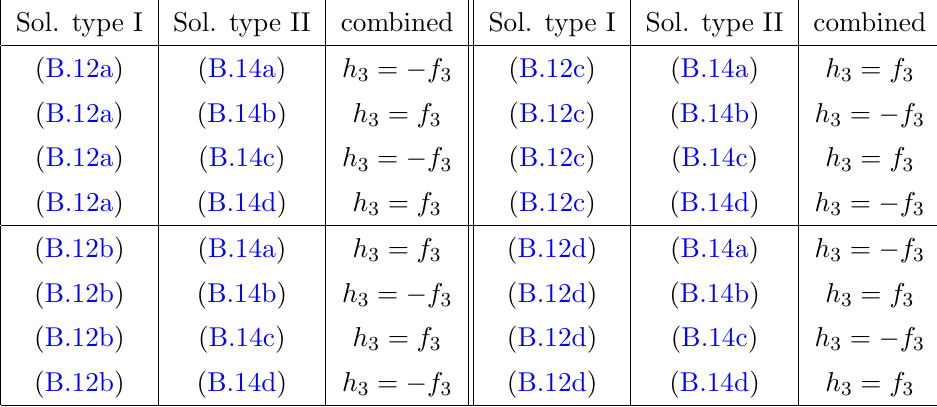
Table 1. Combination of the one-parameter families (B.12) and (B.14) to a exact solution describ- ing two non-trivial triangles. Note that the end points f 3 = (cid:6) 1 correspond the maximal intra-brane Higgs